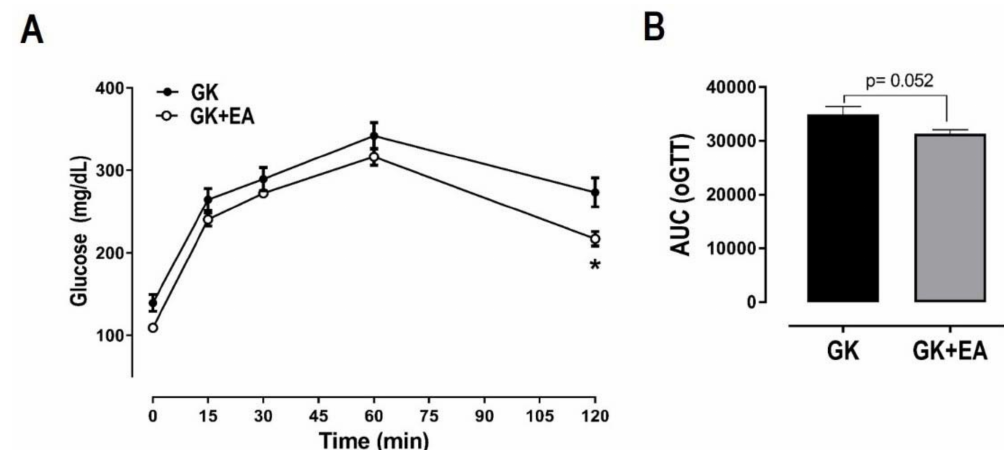
Figure 1. Effect of EA treatment on glucose tolerance in diabetic GK rats. ( A ) oGTT was performed in female diabetic GK rats with or without EA (50 mg/kg) treatment for 45 days. After 10 h fasting, rats received 2 mg/kg glucose solution by oral gavage and blood samples were collected at 15, 30, 45, 60, 75, 90, 105 and 120 min after the administration of glucose solution. Area under the curve of glucose measured during oGTT ( B ). Data are presented as mean ± SEM. ( n = 6 per group); * p < 0.05 vs. GK without EA